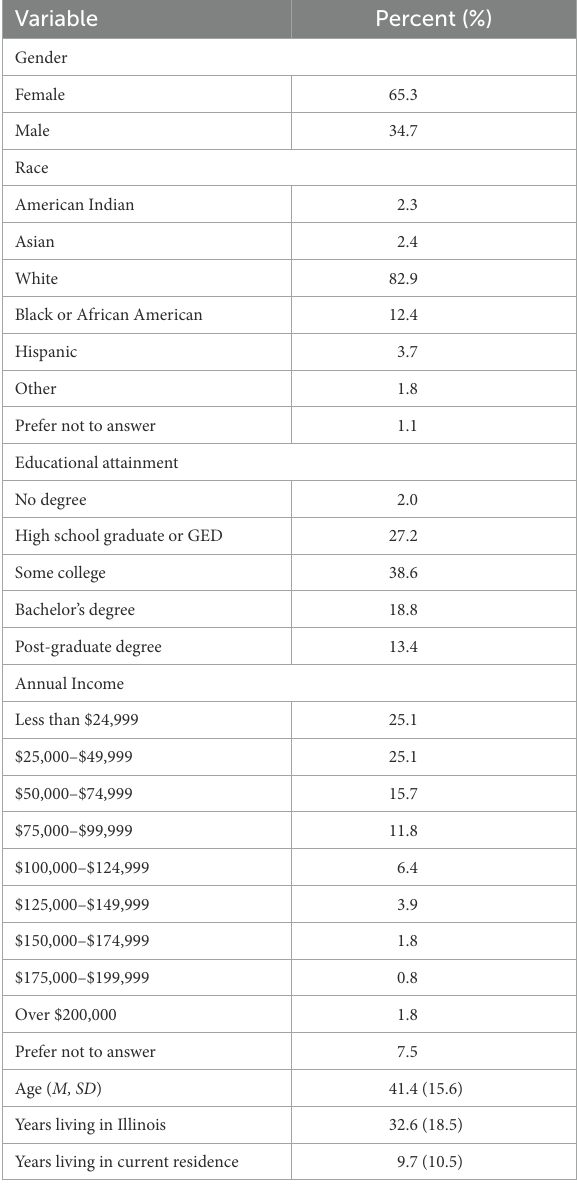
TABLE 3 Socio-demographic characteristics of respondents ( n =